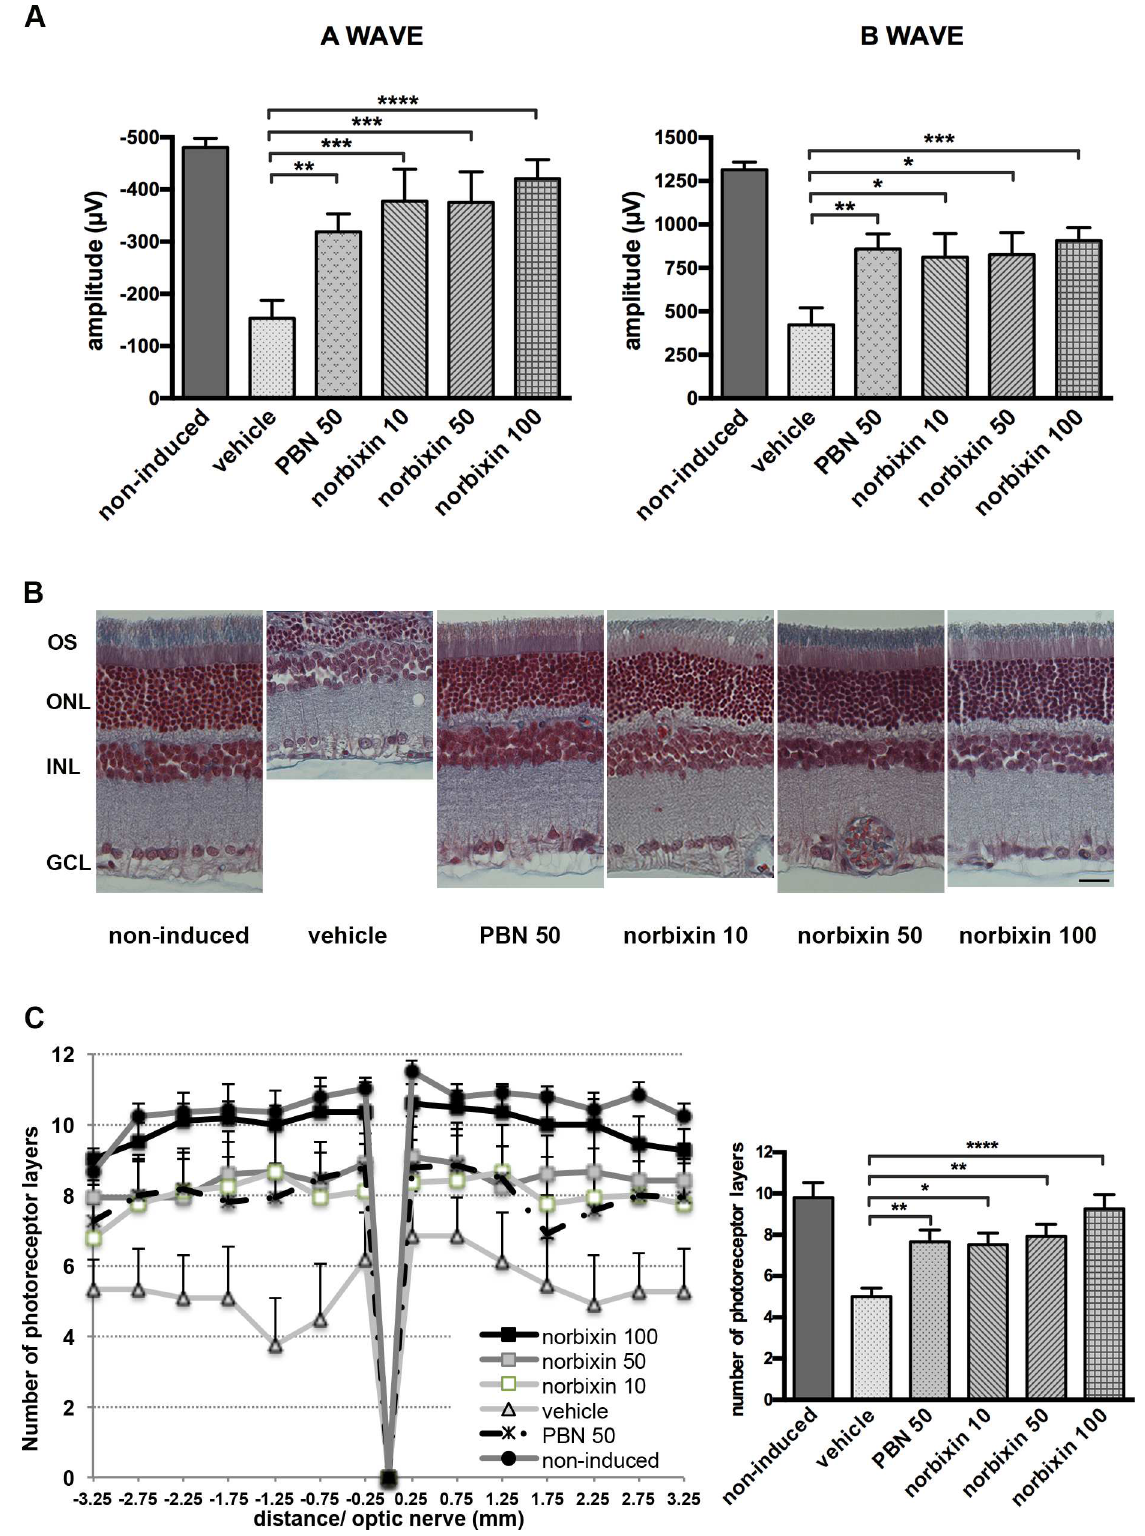
Fig 7. Effect of norbixin on ERG and retinal phototoxicity after BLD in the rat. ERG from rat non-induced or light-exposed which received vehicle, norbixinor PBN. Recordings were on recovery day 7. (A) A- and b-wave amplitudes are presented for